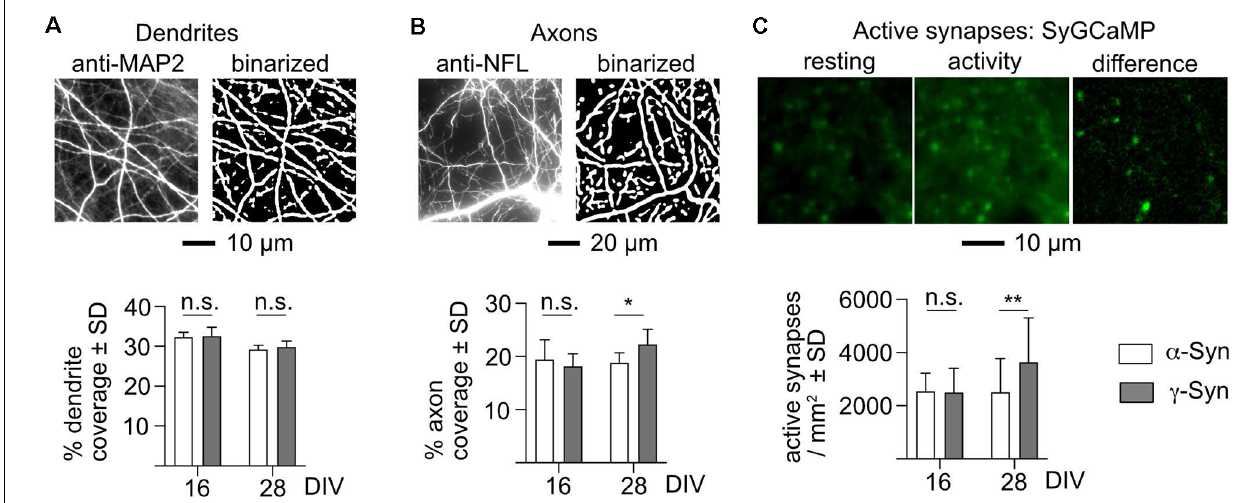
FIGURE 6 | α -Syn expression causes reductions of axon structures and active synapses. (A) Detection of dendrites, shown in the left panel as a fluorescent stain for microtubule-associated protein 2 (MAP2), and in the right panel as a binarized image used for quantification. The bar diagram shows the percent coverage of the binary with dendrite structures for neurons expressing α -Syn (white bars) or γ -Syn (dark bars), at either DIV 16 or DIV 28. (B) Detection of axons, shown in the left panel as a fluorescent stain for neurofilament L (NFL), and in the right panel as a binarized image used for quantification. The bar diagram shows the percent coverage of the binary with axon structures for neurons expressing α -Syn (white bars) or γ -Syn (dark bars), at either DIV 16 or DIV 28. (C) Detection of active presynaptic terminals. The fluorescent signal of SyGCaMP is shown in the resting state, during network activity, and as the resulting difference image, which identifies active synapses. The bar diagram shows the number of active synapses per mm 2 at DIV 16 and DIV 28 for neurons expressing α -Syn (white bars) or γ -Syn (dark bars). N (independent cultures): (A) DIV 16 = 4; DIV 28 = 8; (B) DIV 16 = 6; DIV 28 = 8; (C) DIV 16 = 9; DIV 28 = 28. Statistics by two-tailed unpaired T-tests. n.s. = not significant; * p < 0.05; ** p < 0.01. Statistical power (1 – ß error probability) = 76% (B) , 81% (C)